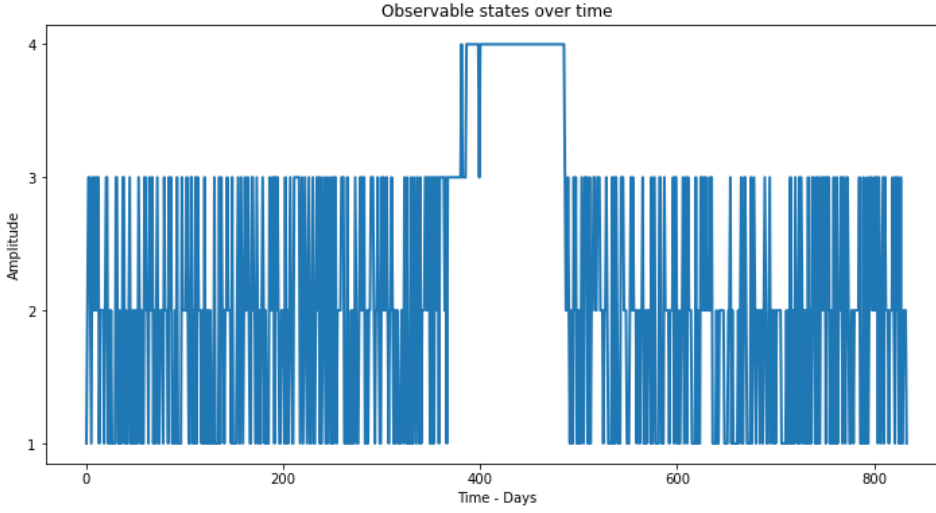
Figure 8. Cluster (optimal observable states) over study